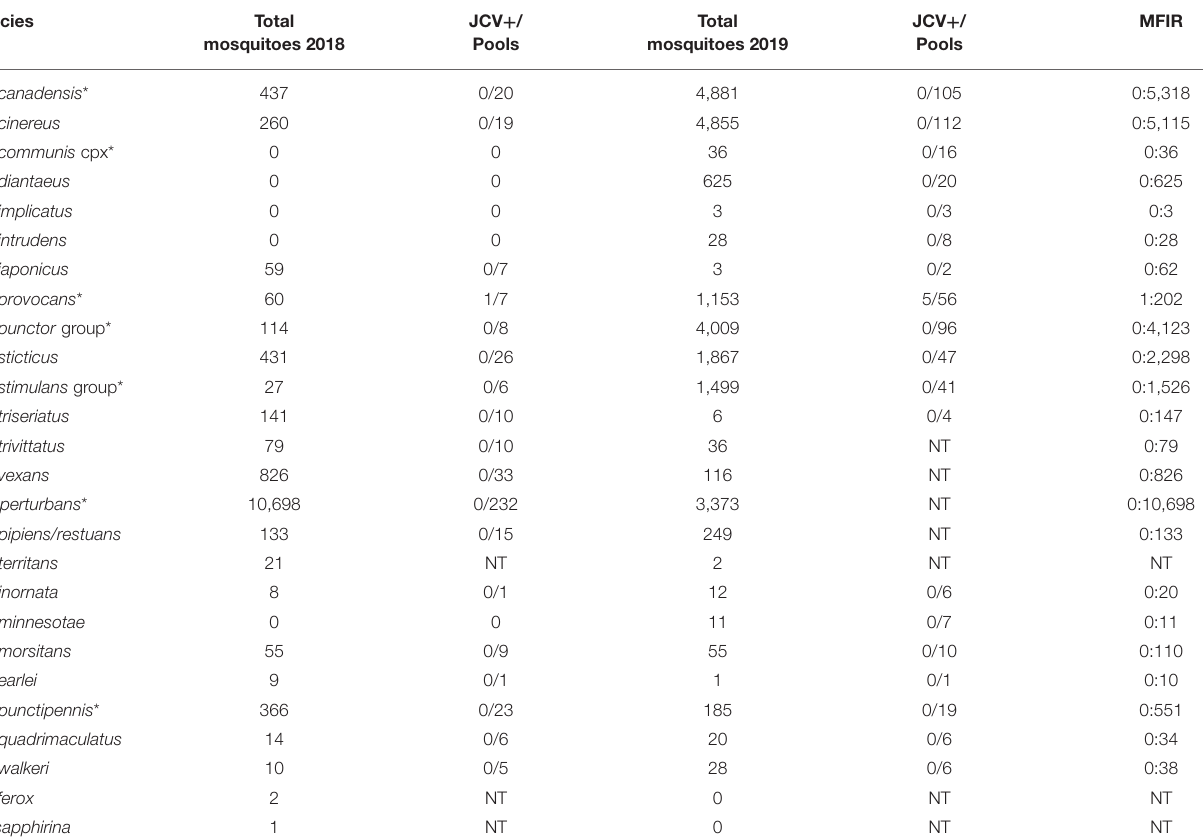
TABLE 4 | Total number of adult female mosquitoes collected in 2018 and 2019, Washburn and Sawyer Counties, Wisconsin, U.S.A., and pooled for JCV testing.